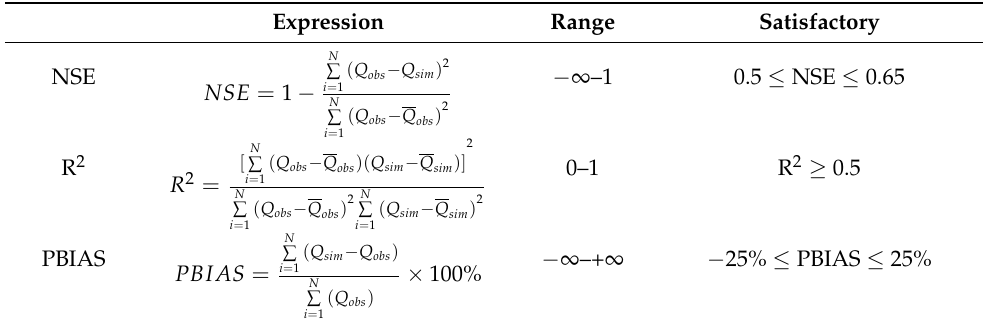
Table 1. Expression of NSE, R 2 and PBIAS. Expression Range